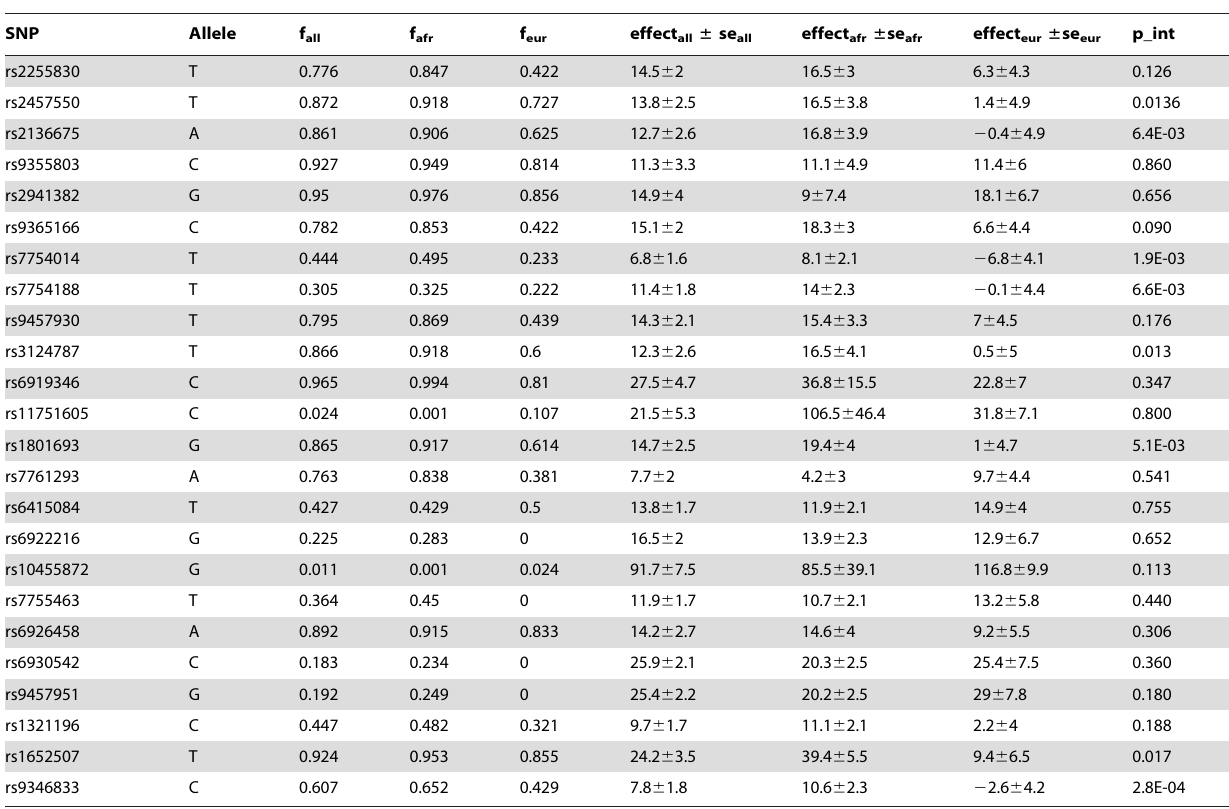
Table 2. Effect Size of LPA variants on Lp(a) levels.